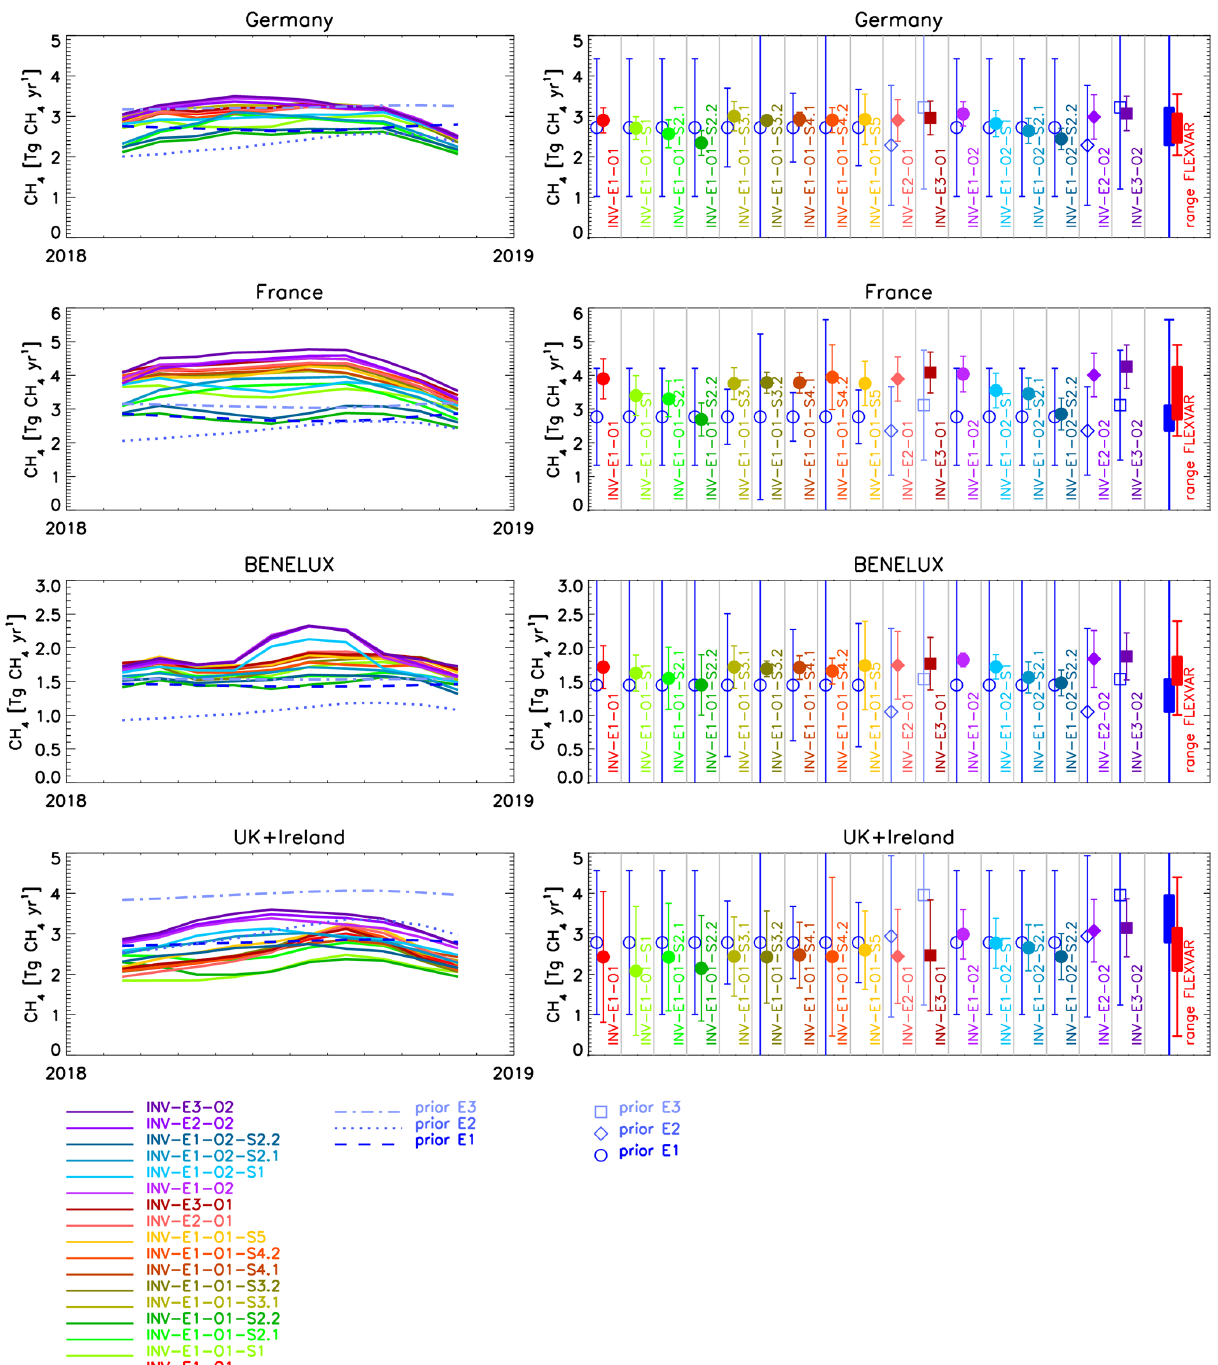
Figure 2. Total CH 4 emissions for Germany, France, BENELUX, and UK + Ireland derived for different sensitivity inversions (Table 3). Left: 3-month running mean total CH 4 emissions of the corresponding country regions. Right: Annual total CH 4 emissions. Open symbols show prior emissions, solid symbols show posterior emissions, and the error bars are the 2 σ uncertainties of prior and posterior emissions, respectively. The solid blue and red rectangles on the right side of the figures show the prior and posterior range from all individual inversions and the error bars on these rectangles the minimum and maximum values of the 2 σ uncertainties of the individual inversions.